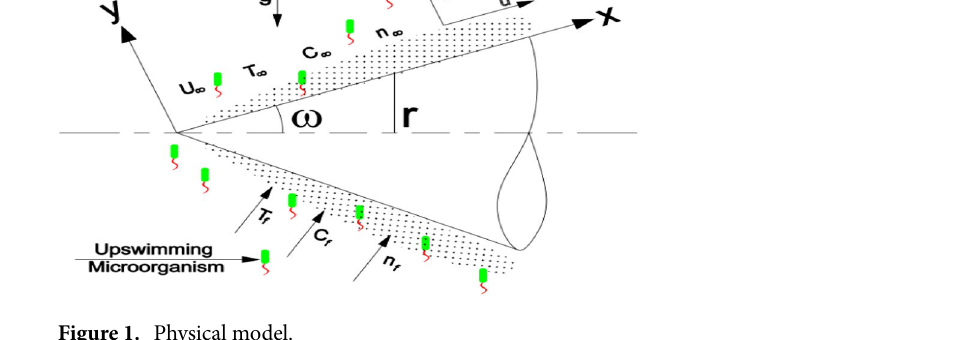
Figure 1. Physical